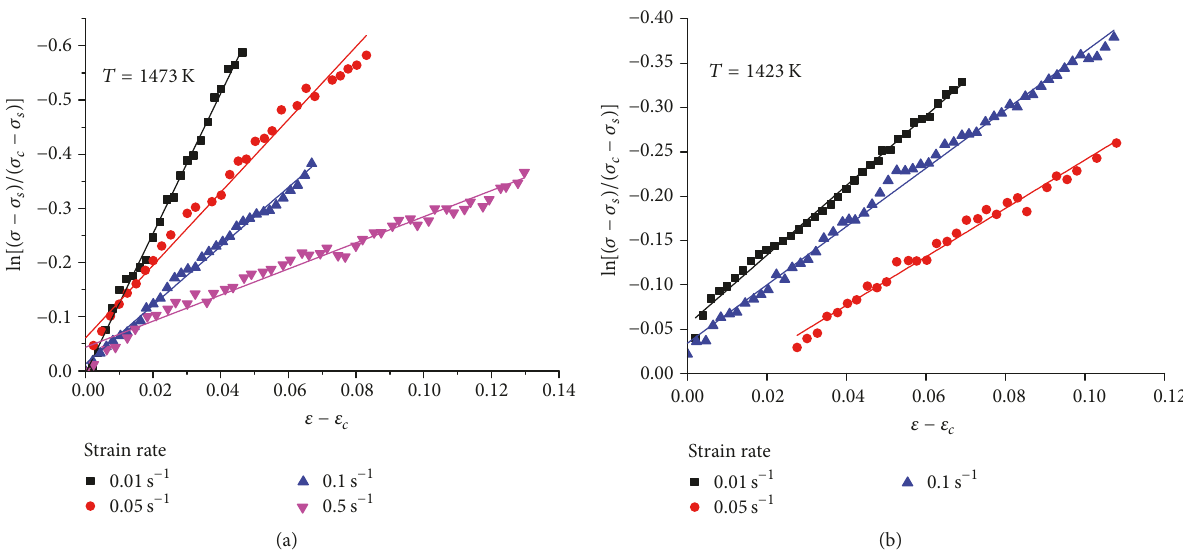
Figure 9: Relationship between (𝜀 − 𝜀 𝑐 ) and ln [(𝜎 − 𝜎 𝑠 )/(𝜎 𝑐 − 𝜎 𝑠 )] at 1473 K (a); 1423 K (b).